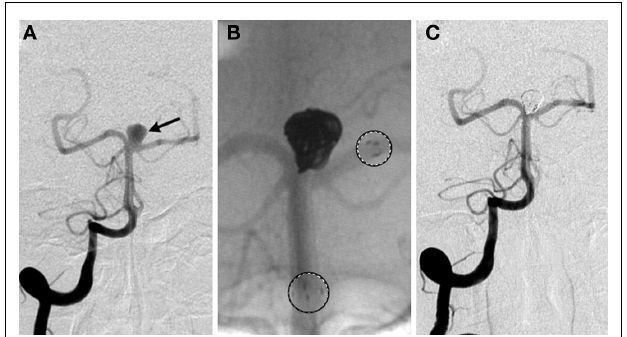
FIGURE 4 | Stent-assisted coil embolization. A 64-year-old woman with headaches and a family history of aneurysms underwent screening and a basilar apex aneurysm was discovered. (A) AP view of a right vertebral artery (VA) injection demonstrates the wide neck aneurysm (arrow).The neck incorporates the origin of the left posterior cerebral artery (PCA). (B) A Neuroform stent (Boston Scientific, Natick, MA, USA) delivery system positioned with the proximal and distal markers (circles) visible on fluoroscopy. Coils were introduced into the aneurysm through a separate microcatheter. (C) Final AP view shows near total occlusion of the aneurysm and preservation of the left